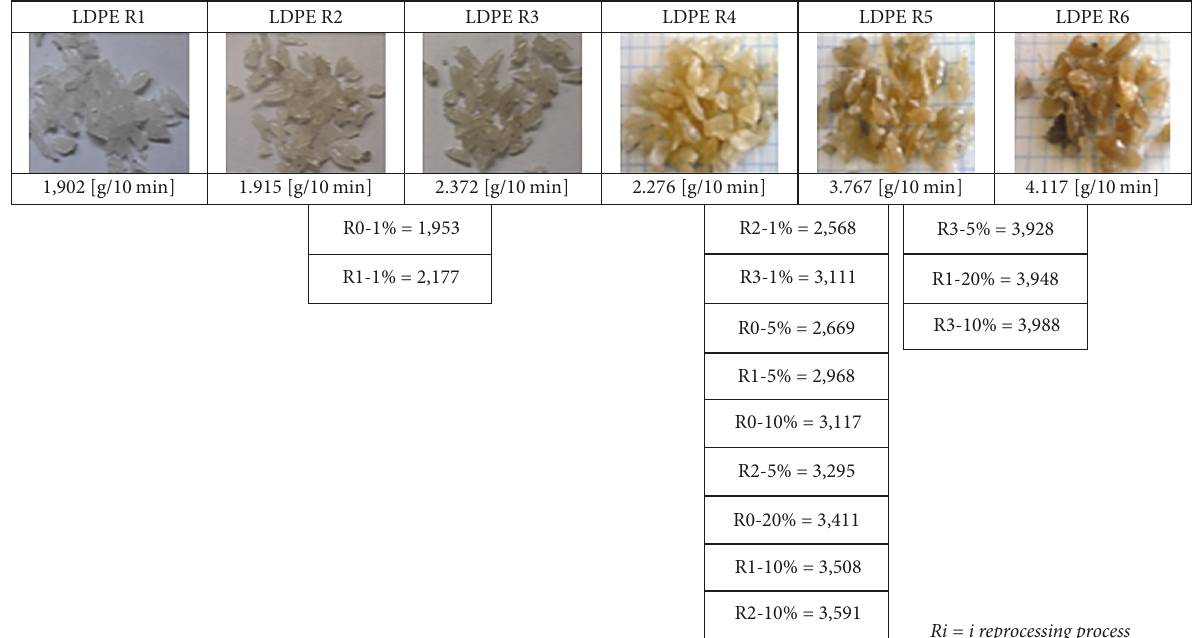
Figure 8. R1, R2, and R3 stand for the number of